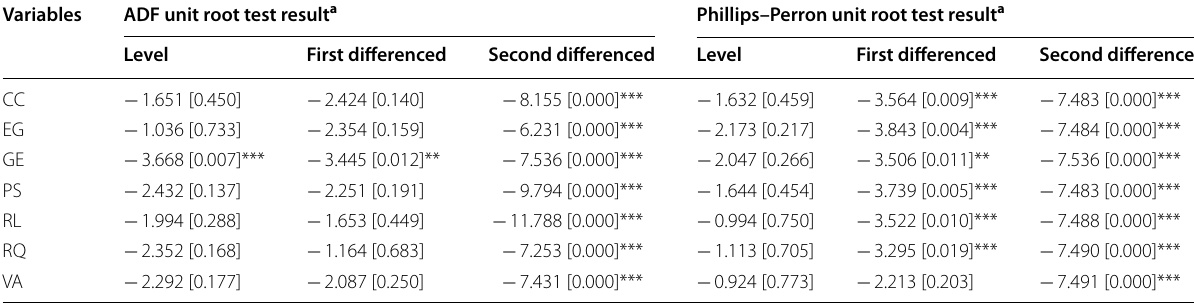
Table 2 Result of unit root test Variables ADF unit root test result